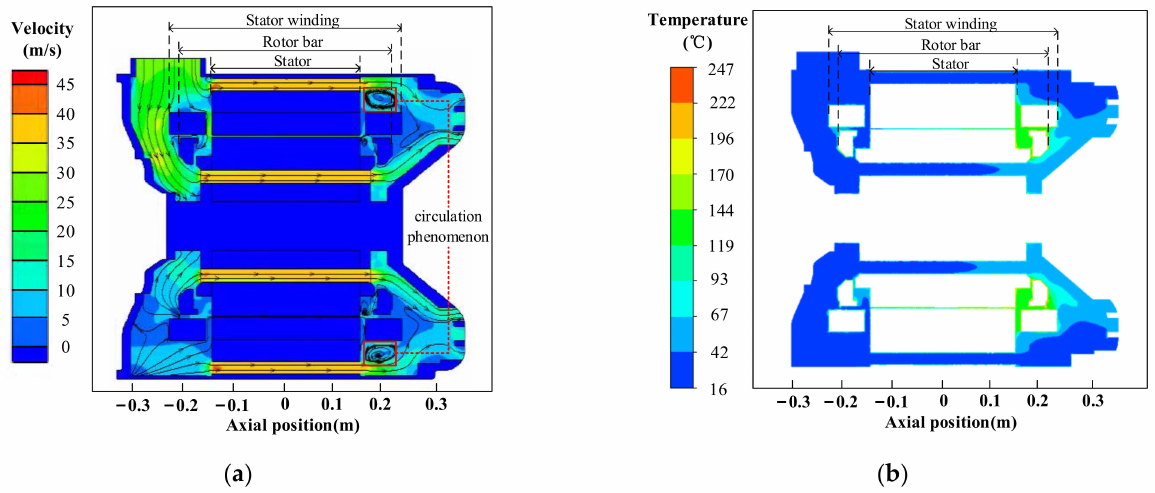
Figure 3. Velocity and temperature distribution of air in the radial section of the original model. ( a ) Velocity distribution of air; ( b ) Temperature distribution of